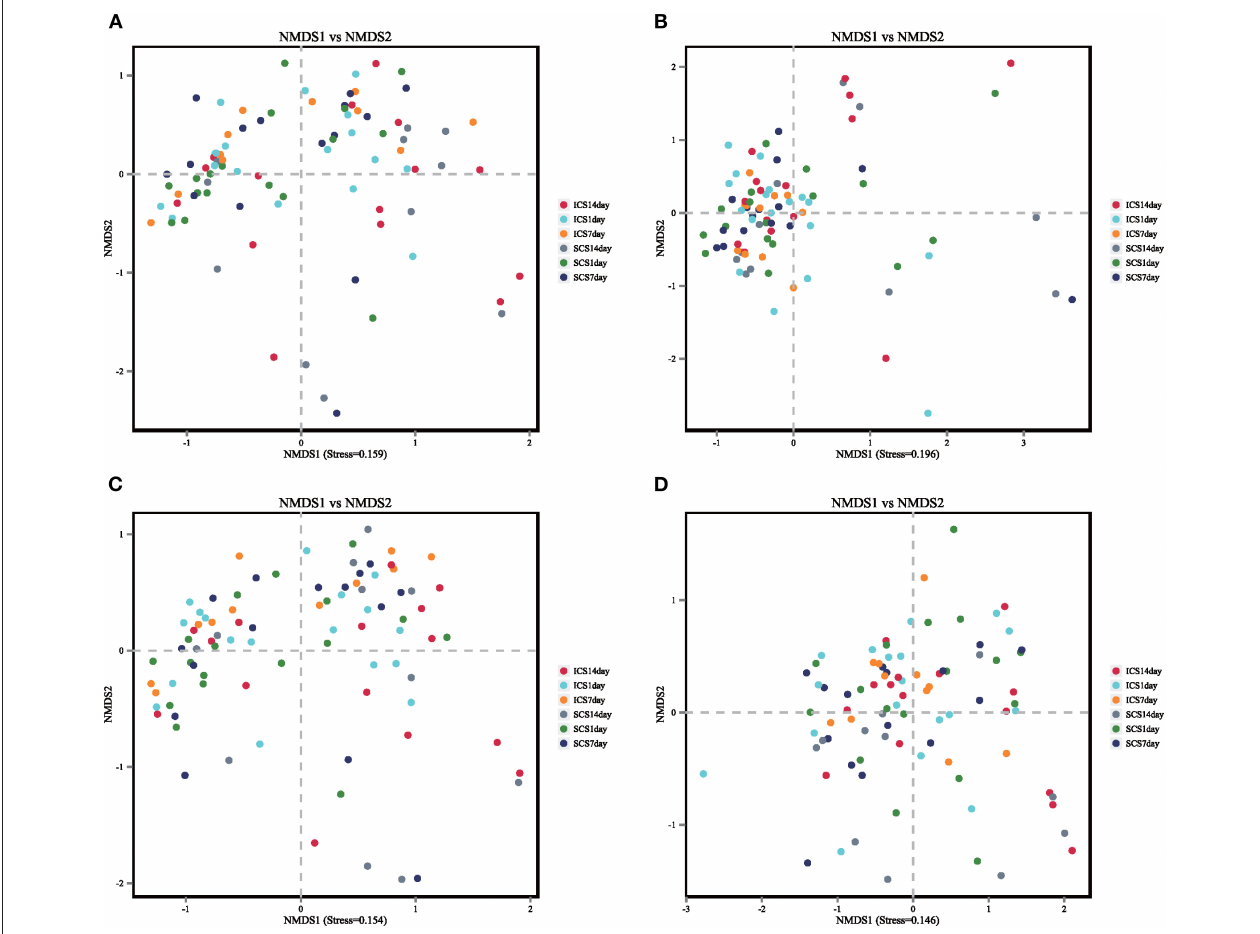
FIGURE 10 | Non-metric multidimensional scaling (NMDS) was used to analyze the colony diversity with the ICS and SCS treatments. The results of NMDS showed that there was no significant difference in bacterial diversity among groups, and ICS and SCS had the same effect on colony diversity via NMDS. Stress < 0.2 in this figure, suggesting that the NMDS analysis is